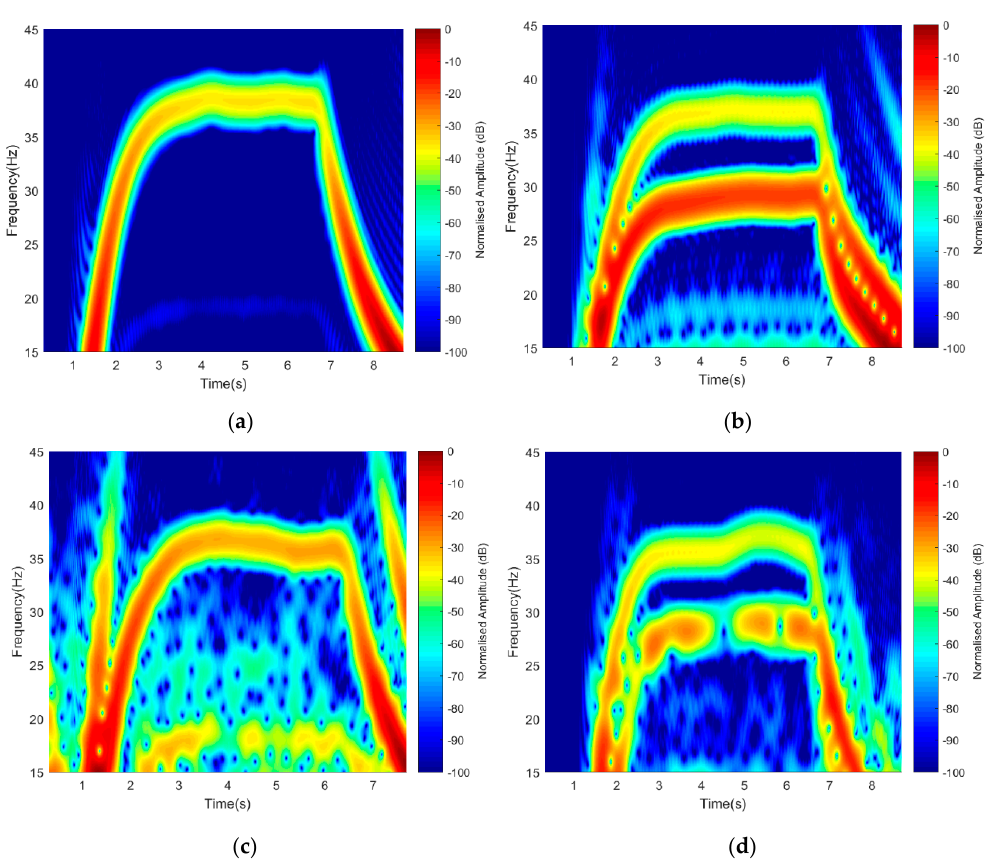
Figure 10. Detected signatures based on blade orientation ( a – b ) Facing-Rx and ( c – d ) Facing-Up. Rx: Figure10. Detectedsignaturesbasedonbladeorientation( a , b )Facing-Rxand( c , d )Facing-Up. Receiver.